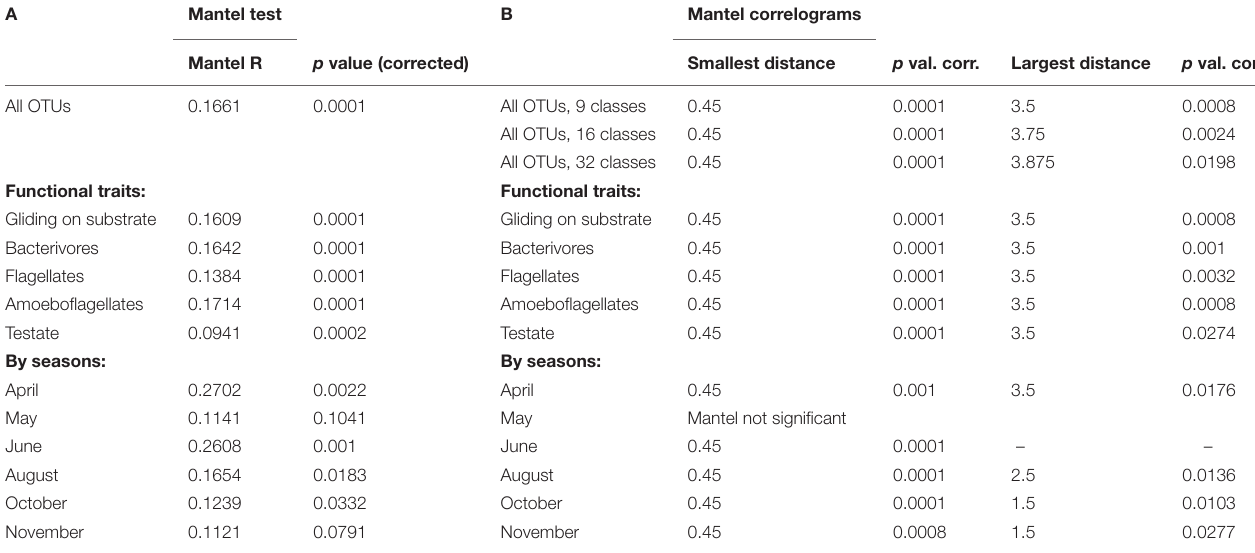
TABLE 2 | Spatial correlations and effect of distance on